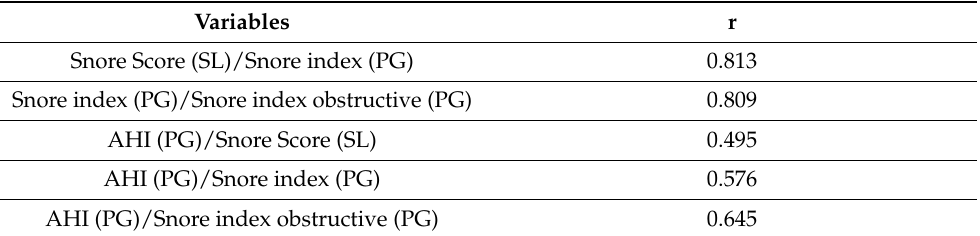
Table 4. Spearman-Rho correlation coefficients (r) for the different scores obtained by the SnoreLab app (SL) and polygraphy (PG).